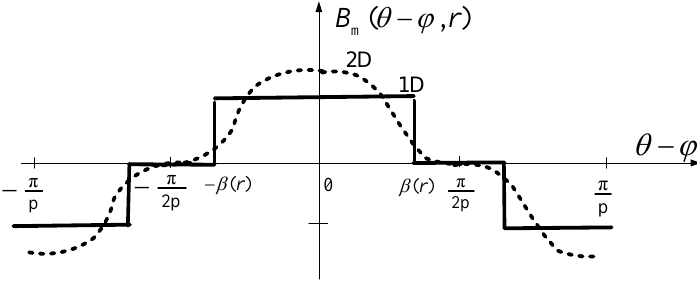
Figure 4. ( a , b ) Arrangement of permanent magnets with an exemplary shape.